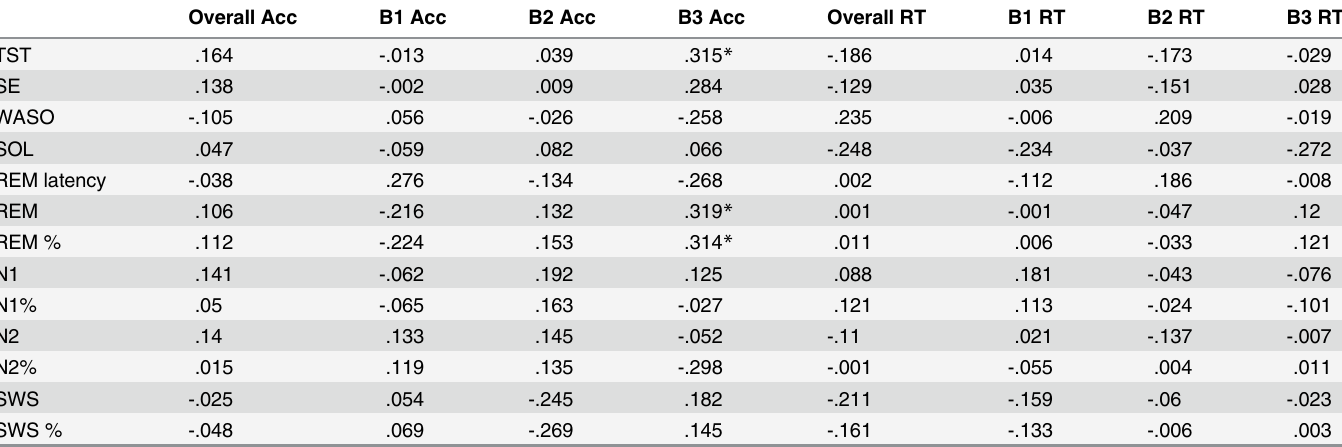
Table 6. Correlational relationships between polysomnographic data and pre-post condition changes on working memory measures among the Nap-group. Overall